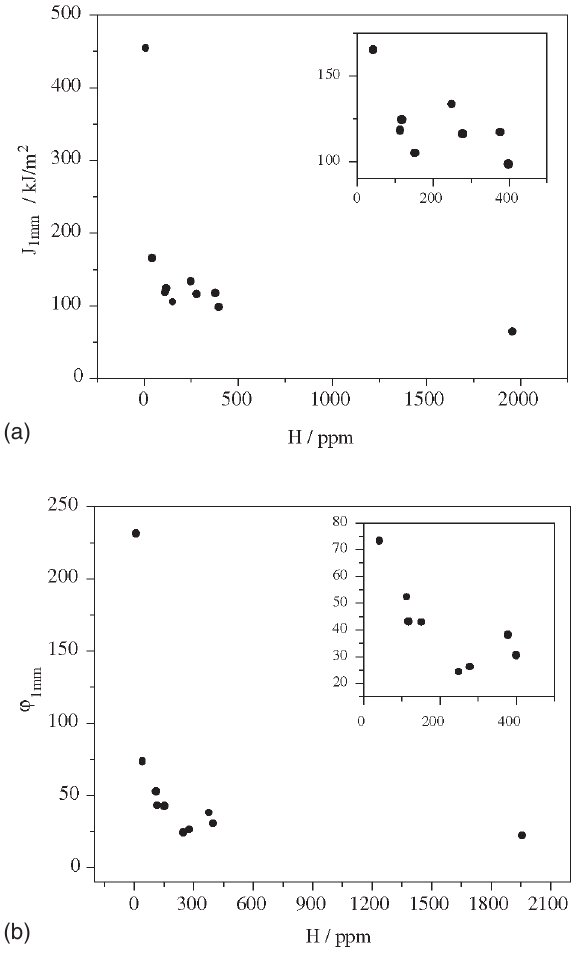
Figure 5. Variation of a) J